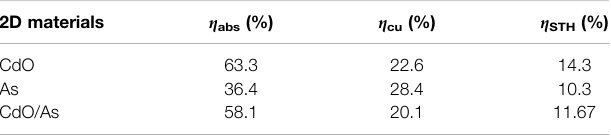
TABLE 2 | The energy conversion ef fi ciency of light absorption ( η abs ), carrier utilization ( η cu ) and STH ( η STH ) of the monolayered CdO, As and CdO/As vdW